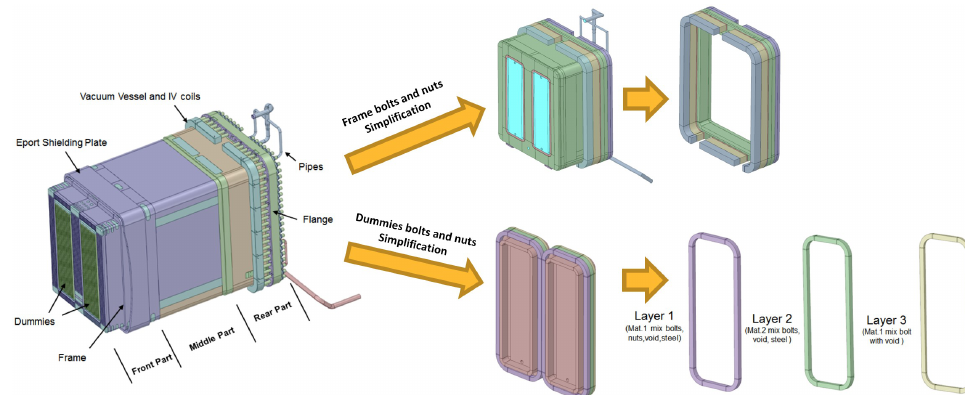
Figure 2. CAD model of the TBM-PP.